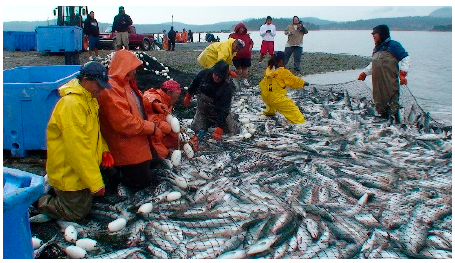
Figure 1. Image of Swinomish “community connection”—beach seiners pulling in a net with salmon. (photo by Jim Gibson).